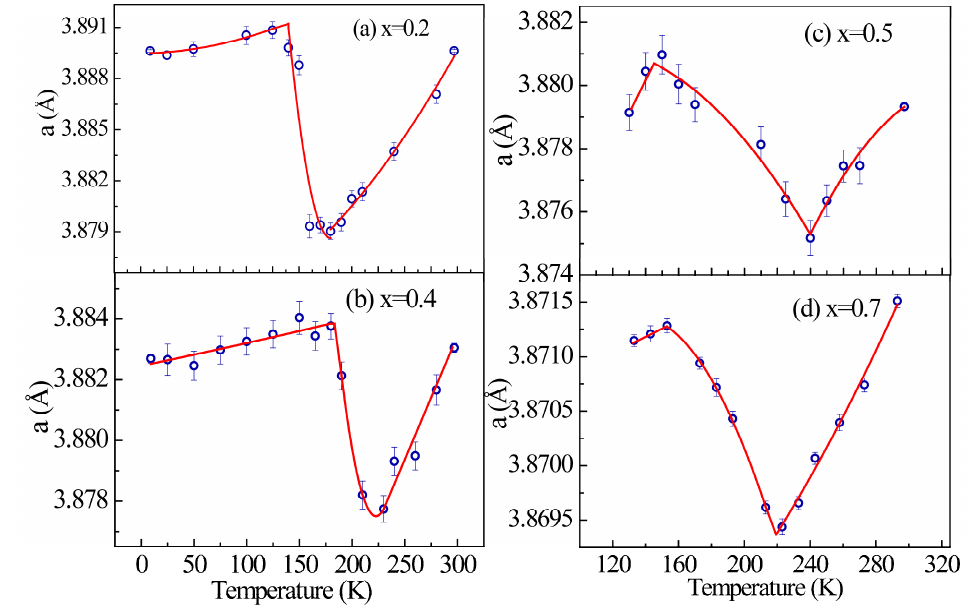
Figure 5. Temperature dependence of the cubic lattice parameter for Mn 3 Zn 1 − x Co x N ( a ) x = 0.2; ( b ) x = 0.4; ( c ) x = 0.5; ( d ) x = 0.7. Negative thermal expansion behavior around the magnetic phase transition was observed.